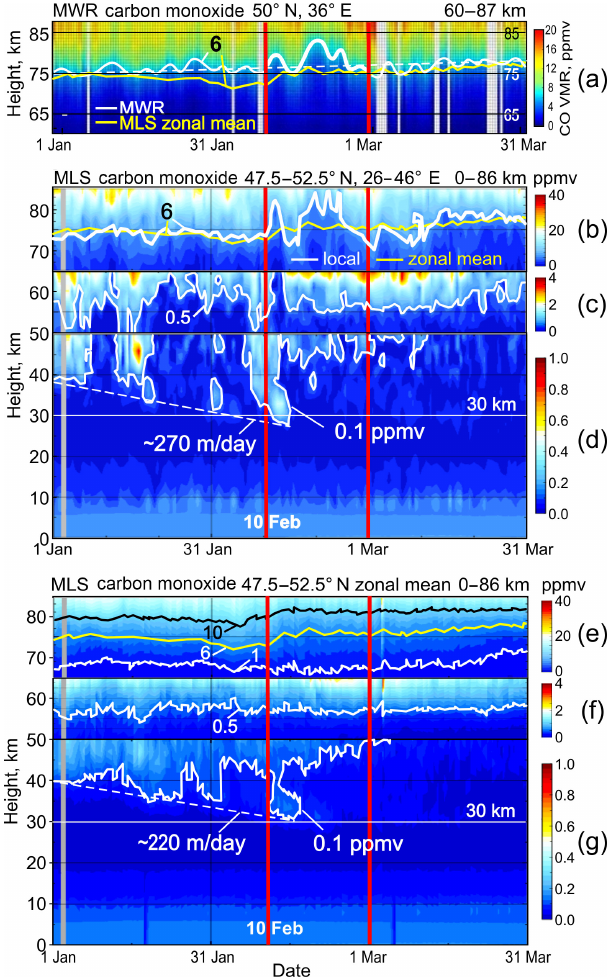
Figure 3. (a) Mesospheric CO profile from microwave measure- ments over Kharkiv averaged in altitude range 70–85km, and ver- tical CO profile from the MLS measurements averaged over lati- tudes 47.5–52.5 ◦ N and longitudes (b–d) 26–46 ◦ E centered at the Kharkiv MWR site (50 ◦ N, 36 ◦ E) and (e–g) 0–360 ◦ E for zonal mean. Selected CO levels are highlighted by white, black, and yel- low contours (see text for details). Data for January–March 2018 are presented and the time interval of significant variations in the atmosphere parameters due to the SSW event (from 10 February to 1 March 2018) is bounded by red vertical lines.